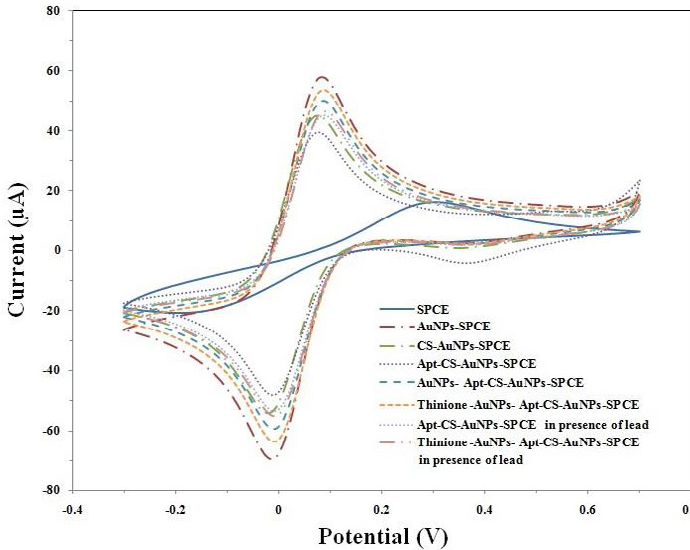
Fig. 2. Cyclic voltammetry reponses of different electrodes. Figure 2. Cyclic voltammetry reponses of different electrodes.